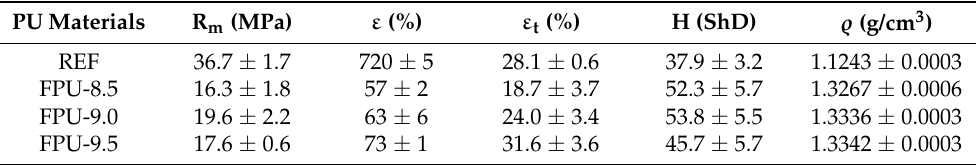
Table 8. Tensile strength (R m ), elongation at break ( ε ), permanent elongation after break ( ε t ), hardness (H) and density ( (cid:36) ) of obtained